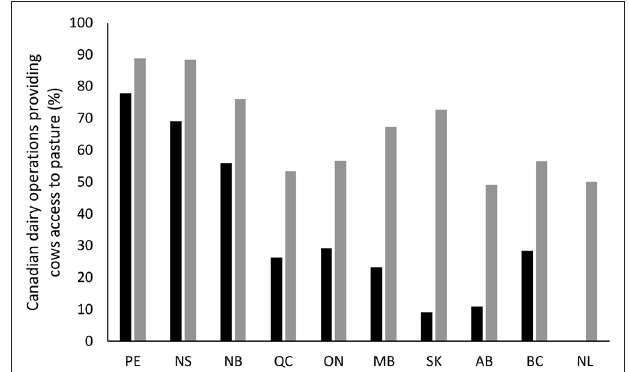
FIGURE 1 | Percentage of operations that allow lactating (black bars) and dry (gray bars) cows access to pasture in Canada, by province (data should be viewed with caution as the survey only had a 9% response